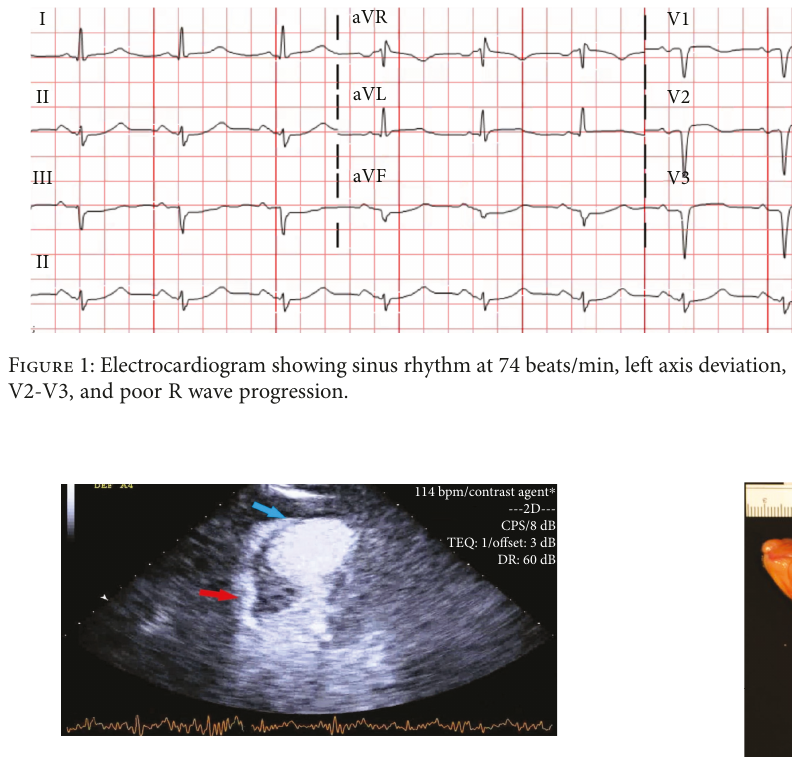
Figure 2: Transthoracic echo showing severely reduced ejection fraction of 30-35%, severe hypokinesis of mid to apical segment with more involvement of the mid anteroseptum, and anterior wall (blue arrow) with basal hyperkinesia and basal asymmetric hypertrophy of the septum (red arrow).